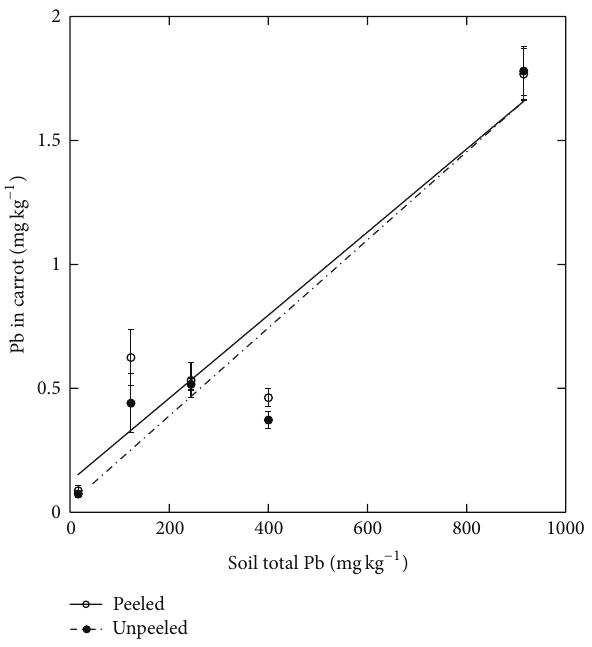
Figure 3: Pb concentrations (mgkg −1 d.w.) in peeled and unpeeled carrot roots grown on orchard soils containing a range of Pb concentrations.